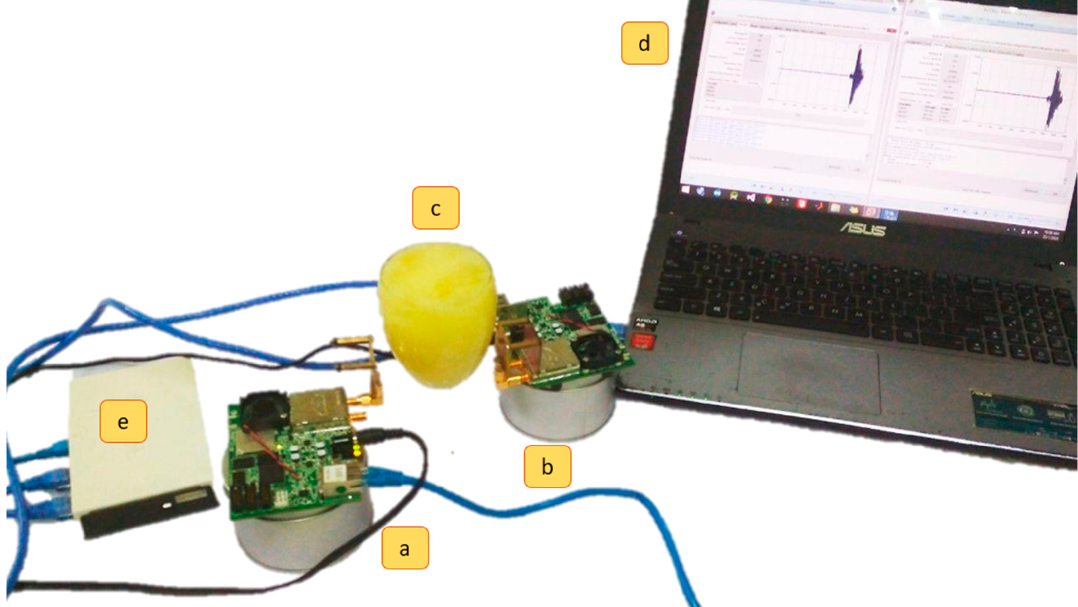
Figure 3. Experimental setup for breast cancer detection: (a) Transmitter; (b) Receiver; (c) Breast Phantom; (d) computer; (e) router.